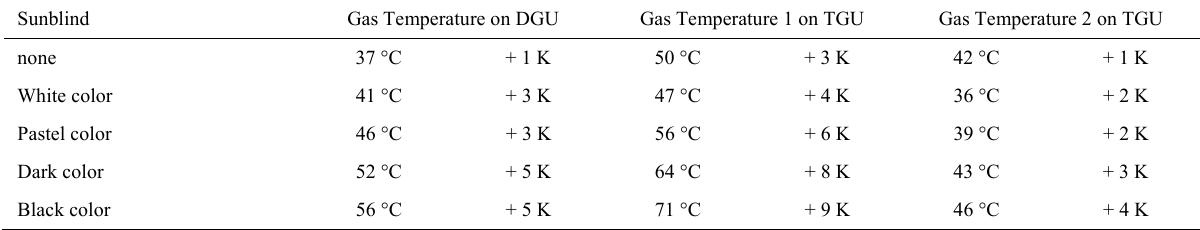
Table 2: Average Gas Temperature of IGU in combination with non-transparent sunblind’s in CCF’s and difference to ventilated DSF (visual sunblind characteristics according to EN 13363-2) Sunblind Gas Temperature on DGU Gas Temperature 1 on TGU